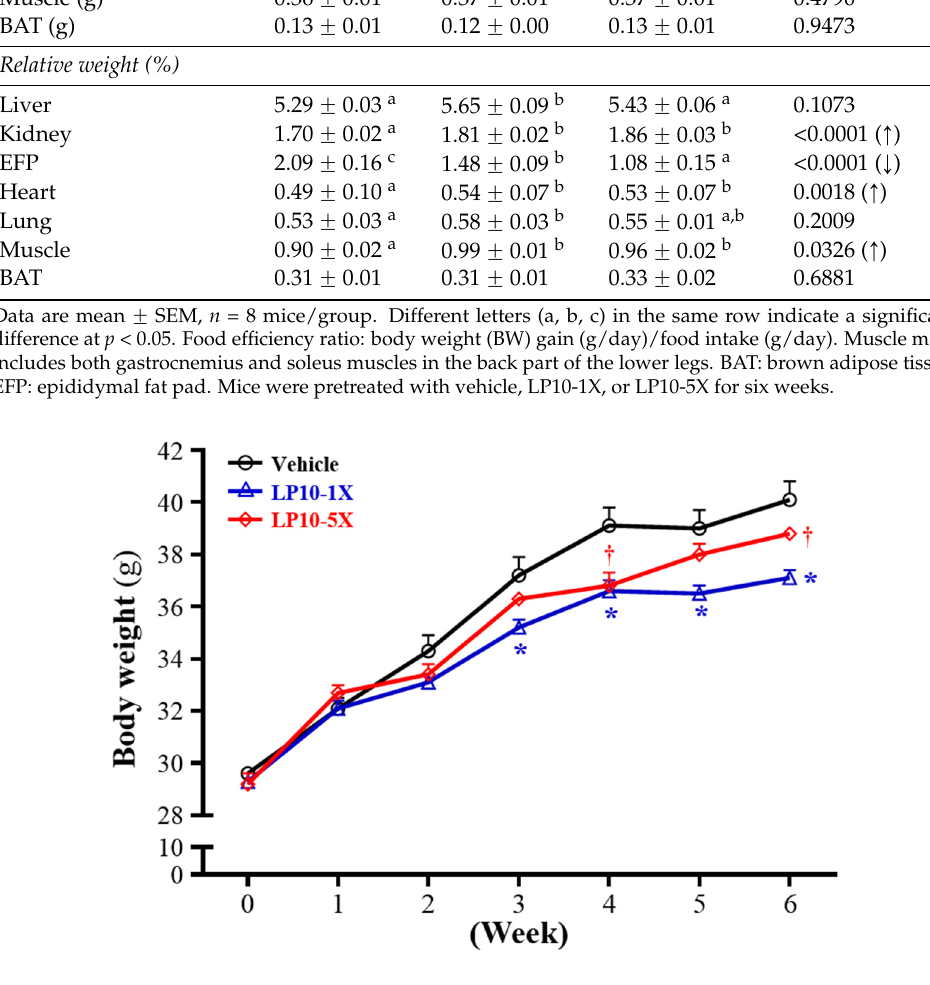
Figure 4. Change in body weight (BW) during the experiment. Data are mean ± SEM, n = 8/group. * p < 0.05, † p < 0.05 for LP10-1X and LP10-5X, respectively, compared with vehicle by one-way ANOVA.